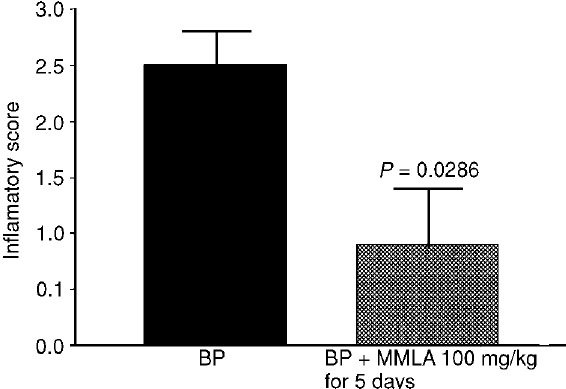
FIG. 2. Mean inflammatory score of mice infected intra- nasally with B. pertussis , and treated with MMLA (100mg/kg i.p. for 5 consecutive days). Mice were sacrificed 10 days after infection.